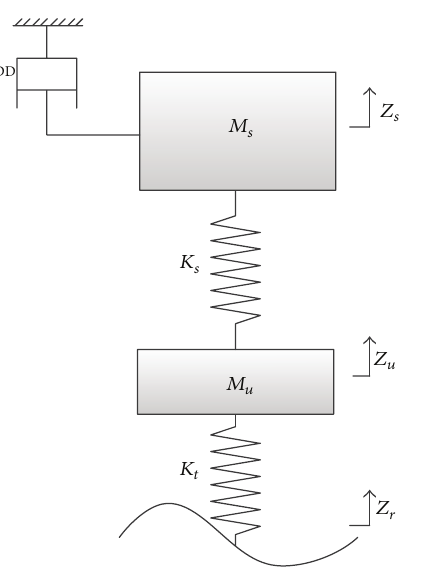
Figure 2: Quarter-vehicle SAS system model with ADD approach.